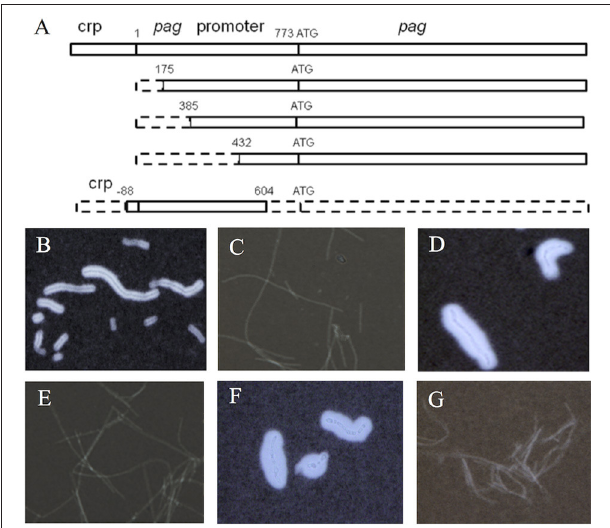
FIGURE 1 | Effect of the pag gene on capsule formation of Pasteur II strain. Diagram of the pag promoter region and pag gene location (A) . The dashed boxes indicate truncated regions; the solid boxes indicate untruncated regions. Microscope images of India ink stained Pasteur II strain (B) , PasteurII-pag promoter KO strain with the longest fragment deletion of the pag promoter region (C) , PasteurII-pag promoterKO-CO strain (D) , PasteurII-pagKO strain (E) , PasteurII-pagKO-CO strain (F) , and negative control, Sterne strain without capsule formation (G) . The images are representative of 3 independent